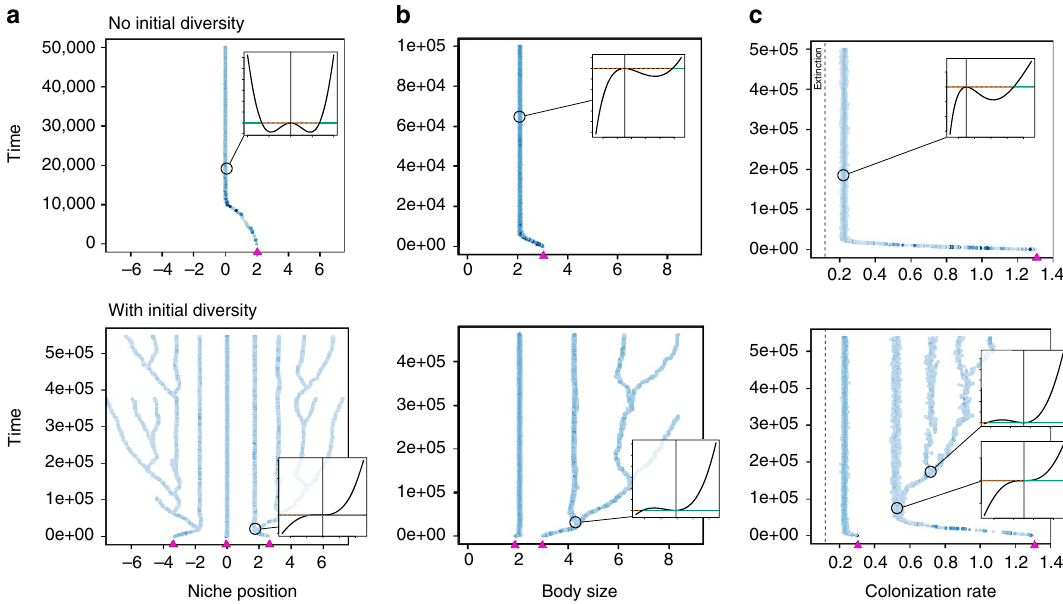
Figure 2 | Instances of diversity-dependent adaptive radiation (DDAR) in evolutionary simulations. Stochastic simulations are shown for the three ecological scenarios ( a – c ; Fig. 1). Trait values are plotted through evolutionary time, darker shades of blue indicate greater relative abundance. In the three panels, adaptive radiation did not occur if starting with only one species (top), but did occur, for the same parameters, if starting with more than one species (bottom). The initial species and their trait values are shown as purple triangles on the x -axes. Fitness landscapes are shown as inserts. The trait value of the focal species (circle) is located by the vertical line, and the invasion fitness of mutants around this value is plotted (Methods section). The horizontal line corresponds to zero fitness; trait values with positive fitness (solid line) can invade, others cannot (dashed